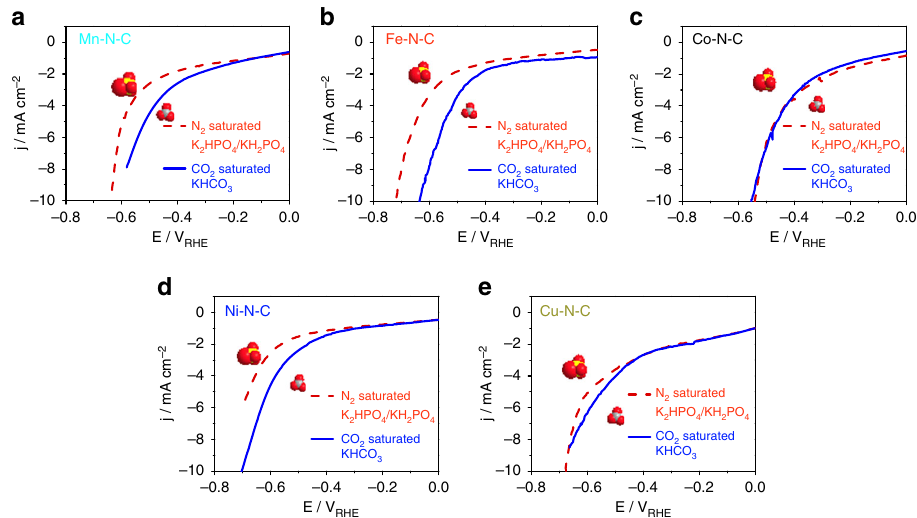
Fig. 3 CO 2 reduction reaction activities. Linear sweep voltammetry of a Mn – N – C, b Fe – N – C, c Co – N – C, d Ni – N – C and e Cu – N – C in CO 2 -saturated 0.1 M KHCO 3 (solid lines) and in N 2 -saturated 0.1 M KH 2 PO 4 /K 2 HPO 4 (dashed lines) with a catalyst loading of 0.76 mg cm − 2 at 5 mV s − 1 in cathodic direction